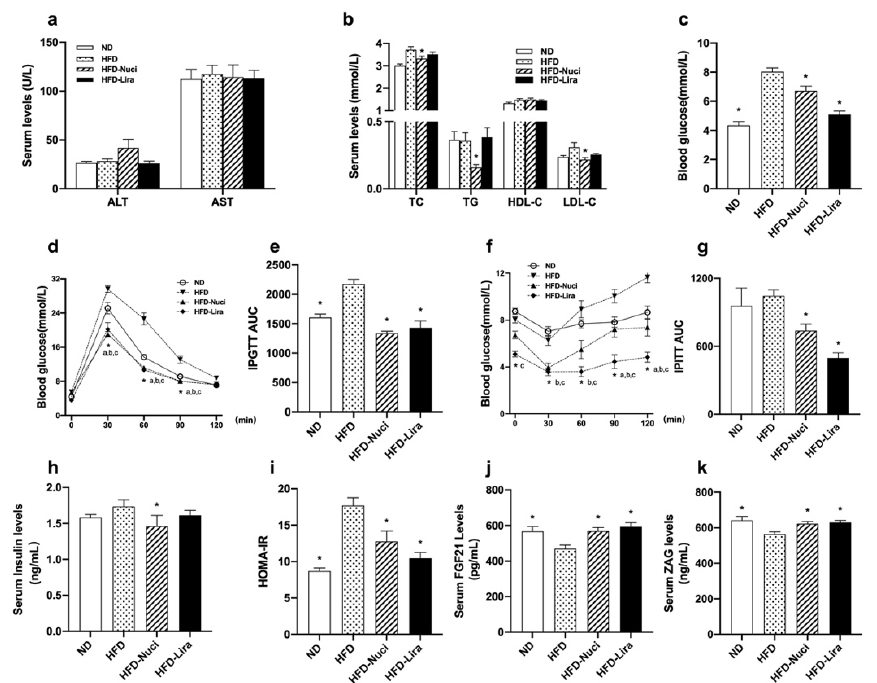
Figure 2. Nuci improved dyslipidemia, glucose tolerance, and insulin resistance in HFD-fed mice. Seven-weeks male C57BL/6J mice were fed with ND, HFD, HFD supplemented with Nuci and HFD with subcutaneous injection of Lira at 200 µ g/kg/day for 12 weeks. Liver function markers including ALT and AST ( a ), lipid metabolism-related traits including TC, TG HDL-C, and LDL-C ( b ) and fasting blood glucose ( c ) were examined. The intraperitoneal glucose tolerance test (IPGTT, ( d )) and the intraperitoneal insulin tolerance test (IPITT, ( f )) were performed at the 10th week, and area under curves (AUCs) of IPGTT ( e ) and IPITT ( g ) were calculated. FINS ( h ) was determined, and HOMA-IR ( i ) was calculated accordingly. Serum levels of FGF21 ( j ) and ZAG ( k ) were determined by ELISA. Data were presented as mean ± SE, n = 12 in each group. * p < 0.05 vs. the HFD group. In Figure 2d and f, * a, the ND vs. the HFD group; * b the HFD-Nuci vs. the HFD group; * c the HFD-Lira vs. the